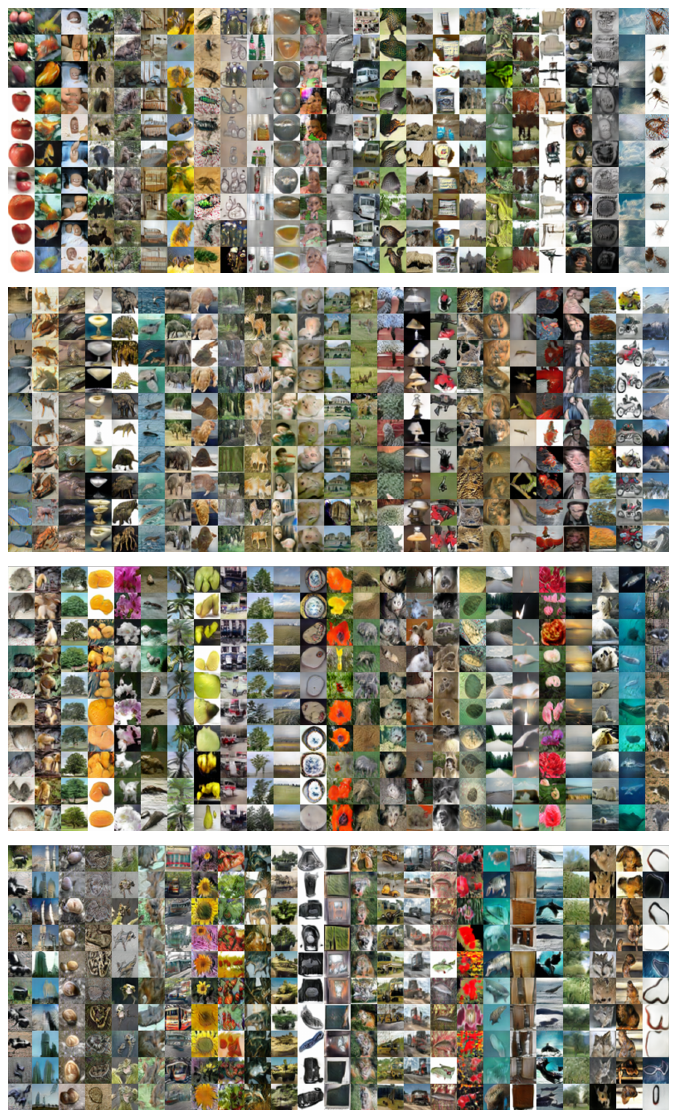
Figure 4. Random examples of the generated images by ScoreGAN with the CIFAR-100 dataset. Each column represents each class in the CIFAR-100 dataset. All images have a 32 × 32